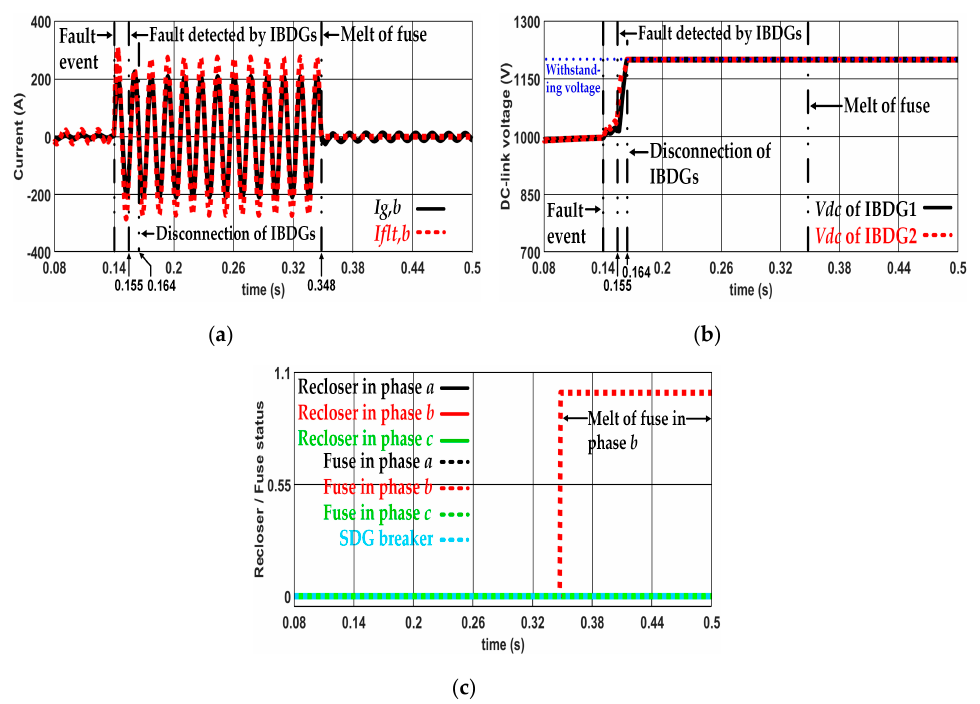
Figure 9. Conventional current control during temporary SLG fault: ( a ) total fault current and grid current; ( b ) DC-link voltage; and ( c ) operating time of recloser–fuse and SDG breaker.